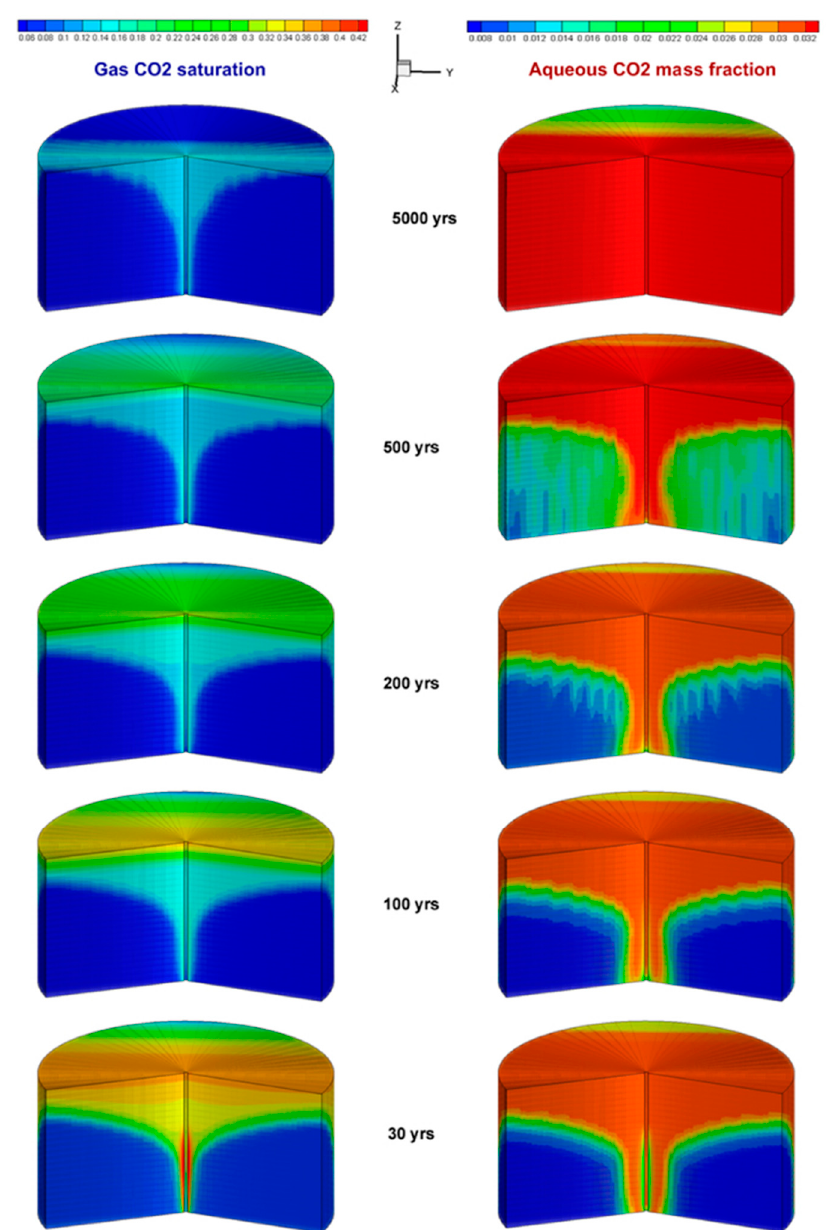
Figure 2. Free gas saturation and aqueous (dissolved) CO 2 mass fraction contours for a 3D homogeneous model at different time steps (case Base ‐ 3D in Table 1).